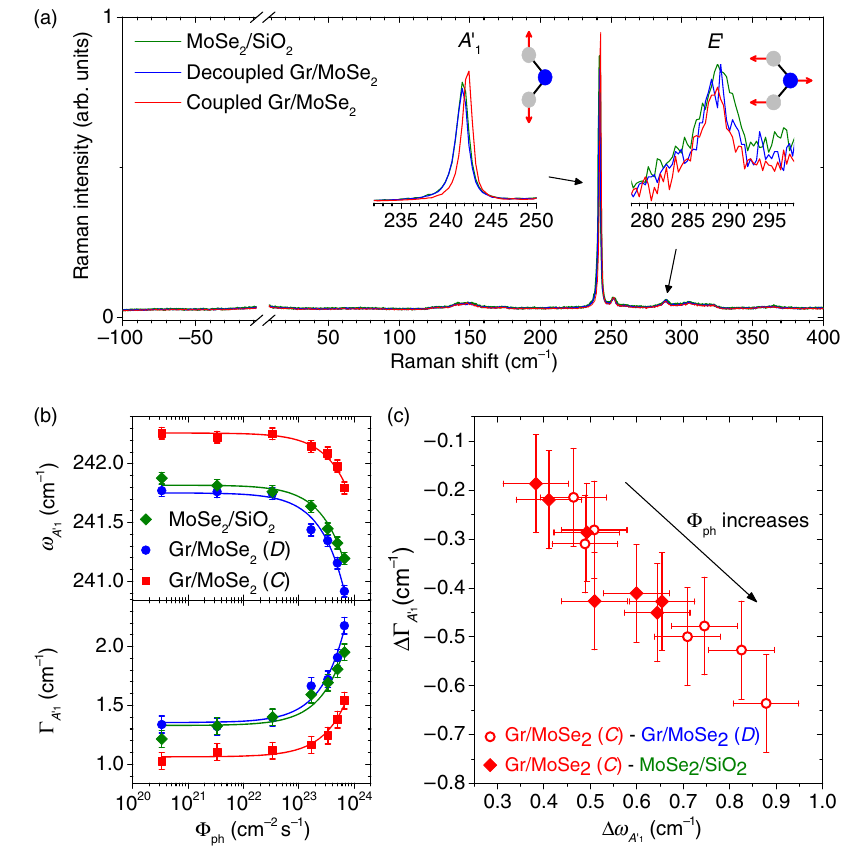
¼ 3 . 3 × 10 22 cm − 2 s − 1 for MoSe = SiO C , in 2 2 (green), coupled ( ph for MoSe 2 = SiO 2 (green diamonds), coupled (red squares) ph as a function 1 for coupled and decoupled Gr = MoSe 2 (open circles), and for coupled 1